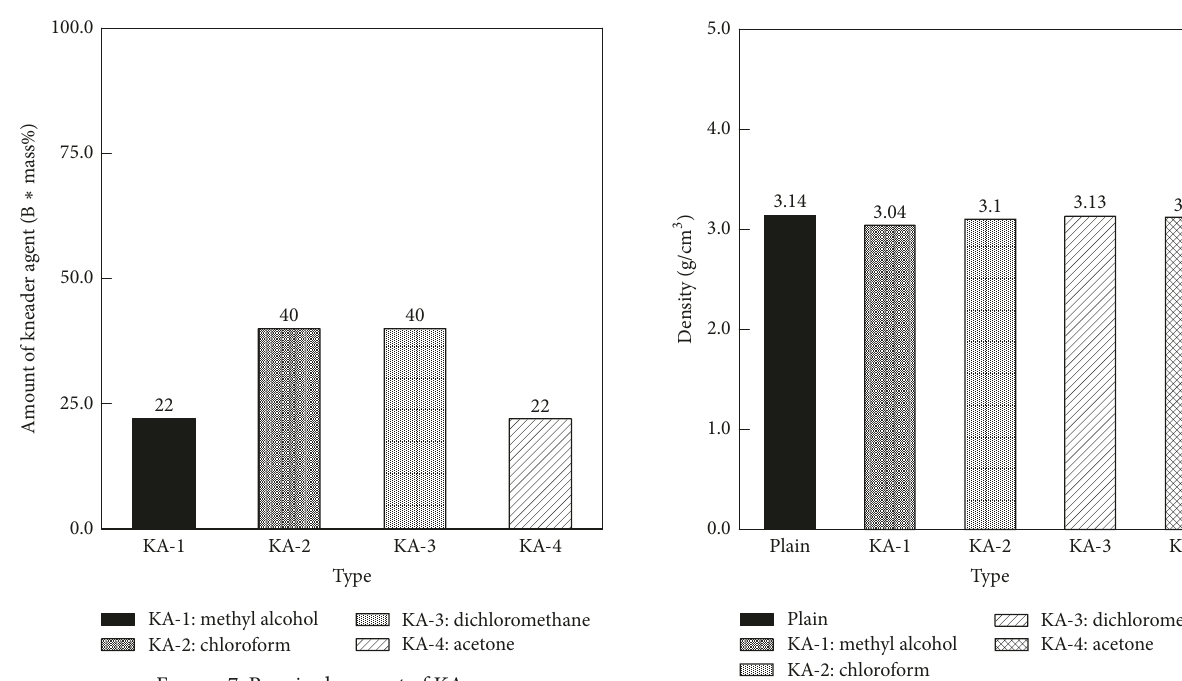
Figure 8: Density of core material according to KA